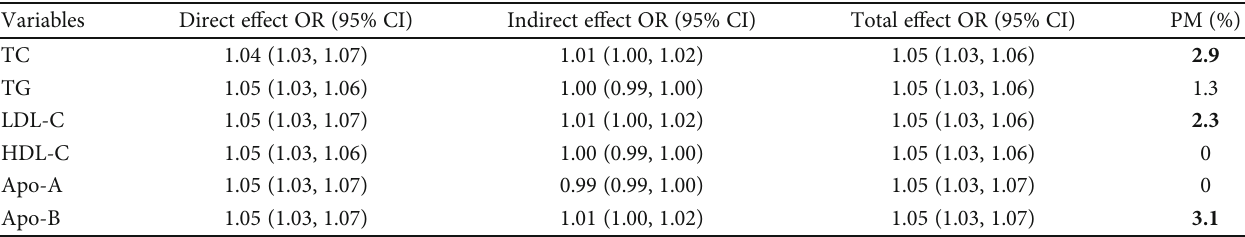
Table 3: Mediation analysis of the association between the KCNQ1 rs2237895 and T2DM risk mediated by lipid parameters.